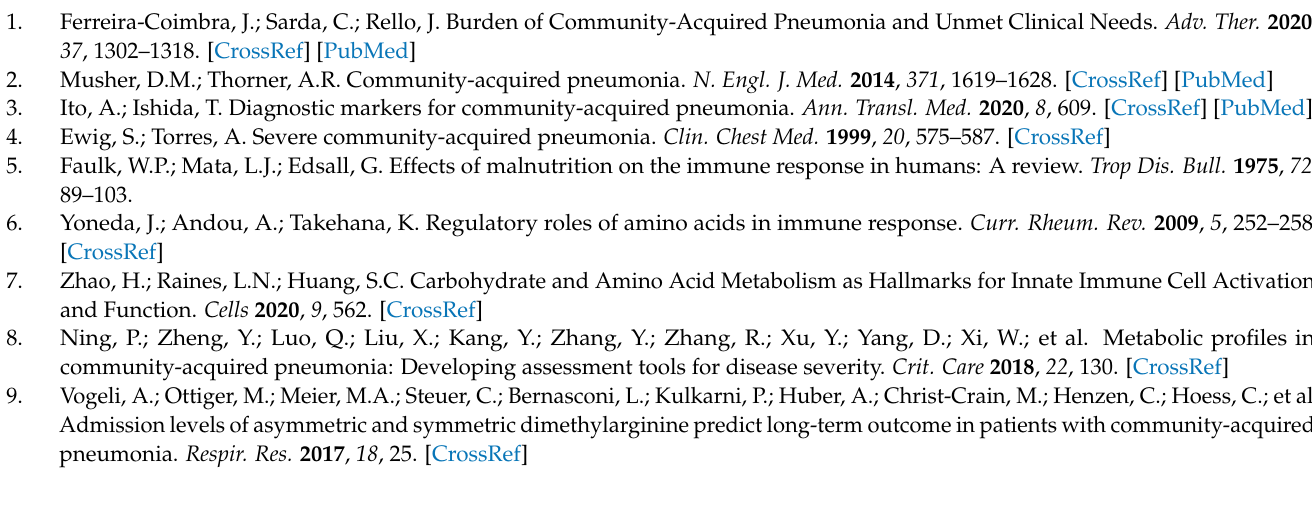
Table S4. Results of oversampling procedure, modeling the effect of increasing sample size of COPD to sample size of CAP ( n = 29)